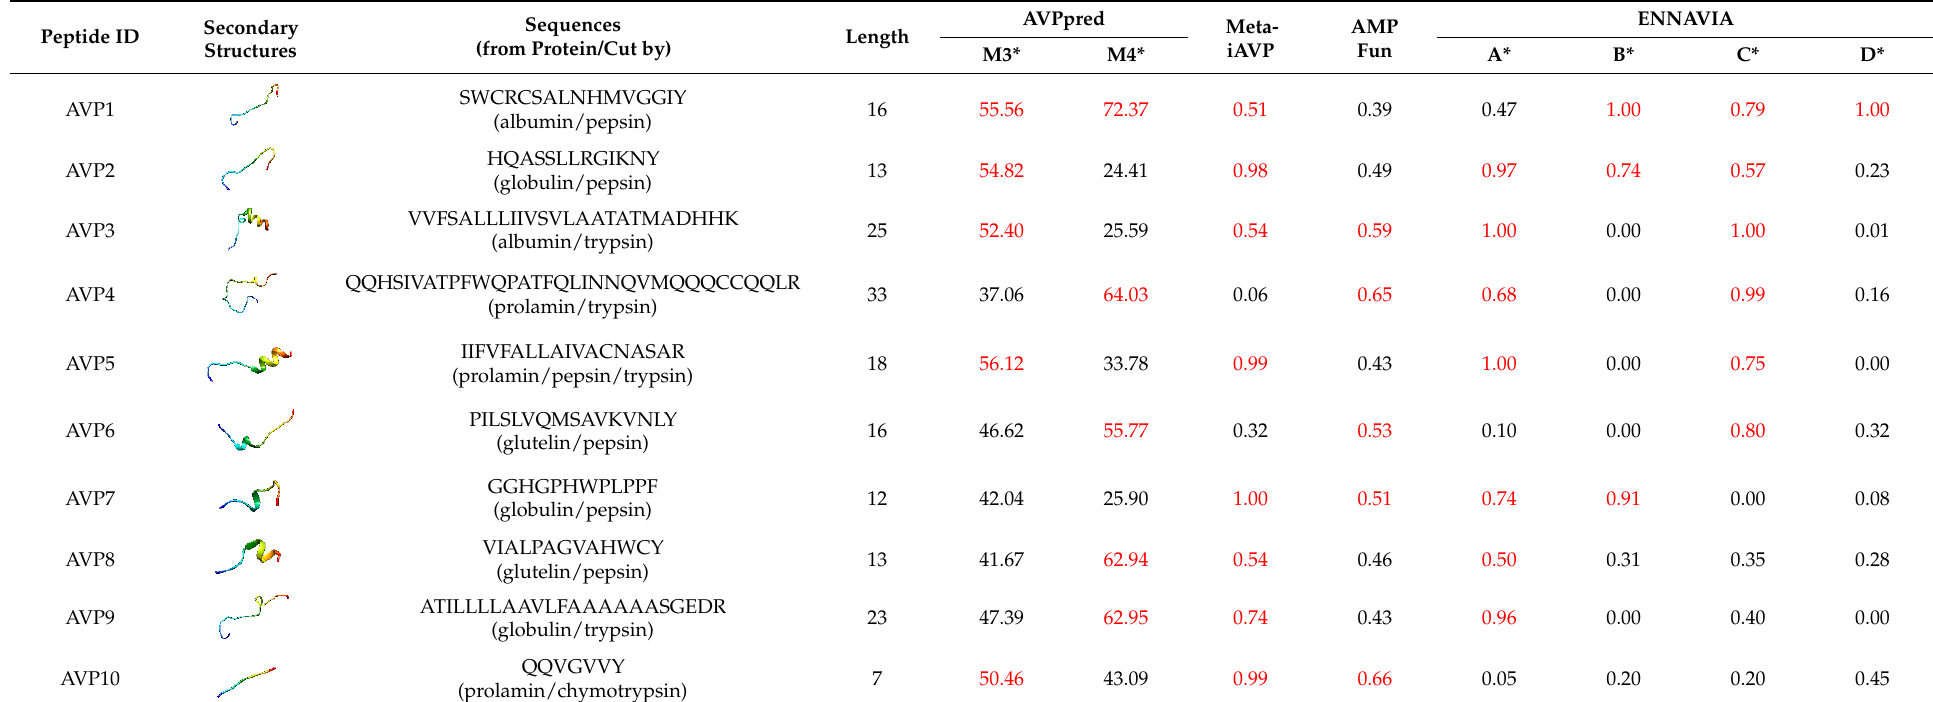
Table 1. Predictive probability scores or SVM scores from antiviral peptide prediction tools.